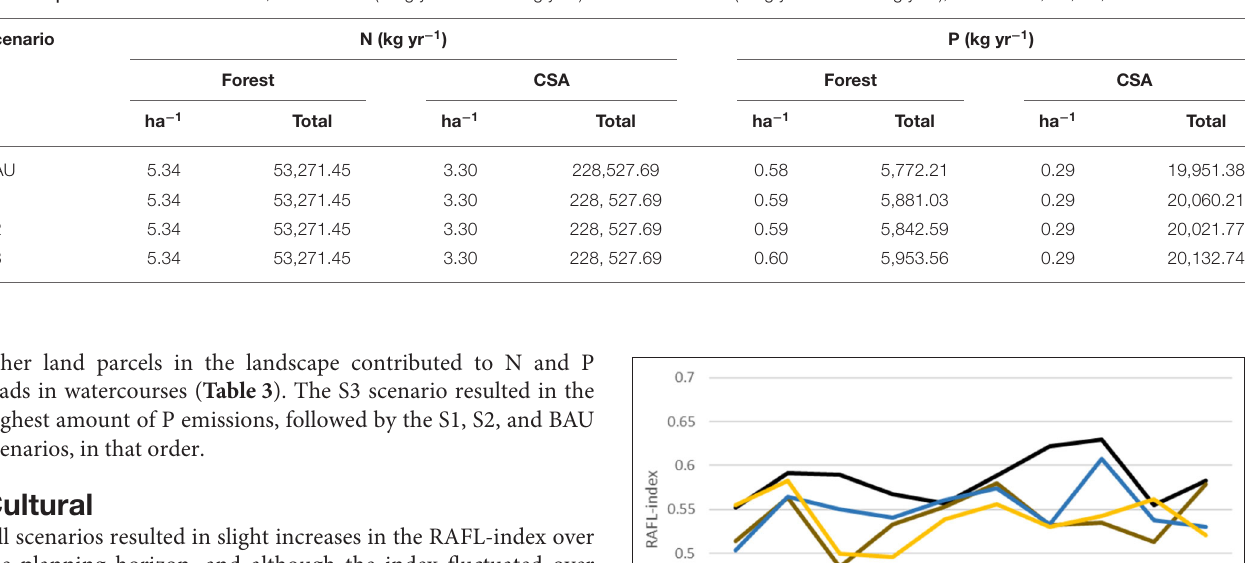
TABLE 3 | Emission levels for N and P, for the forest (in kg yr − 1 ha − 1 and kg yr − 1 ) and the entire CSA (in kg yr − 1 ha − 1 and kg yr − 1 ), for the BAU, S1, S2, and S3 scenarios.